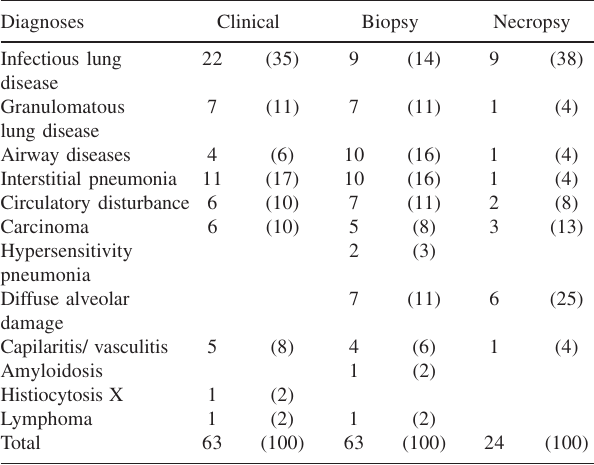
Table 3 - Distribution of clinical, biopsy and necropsy